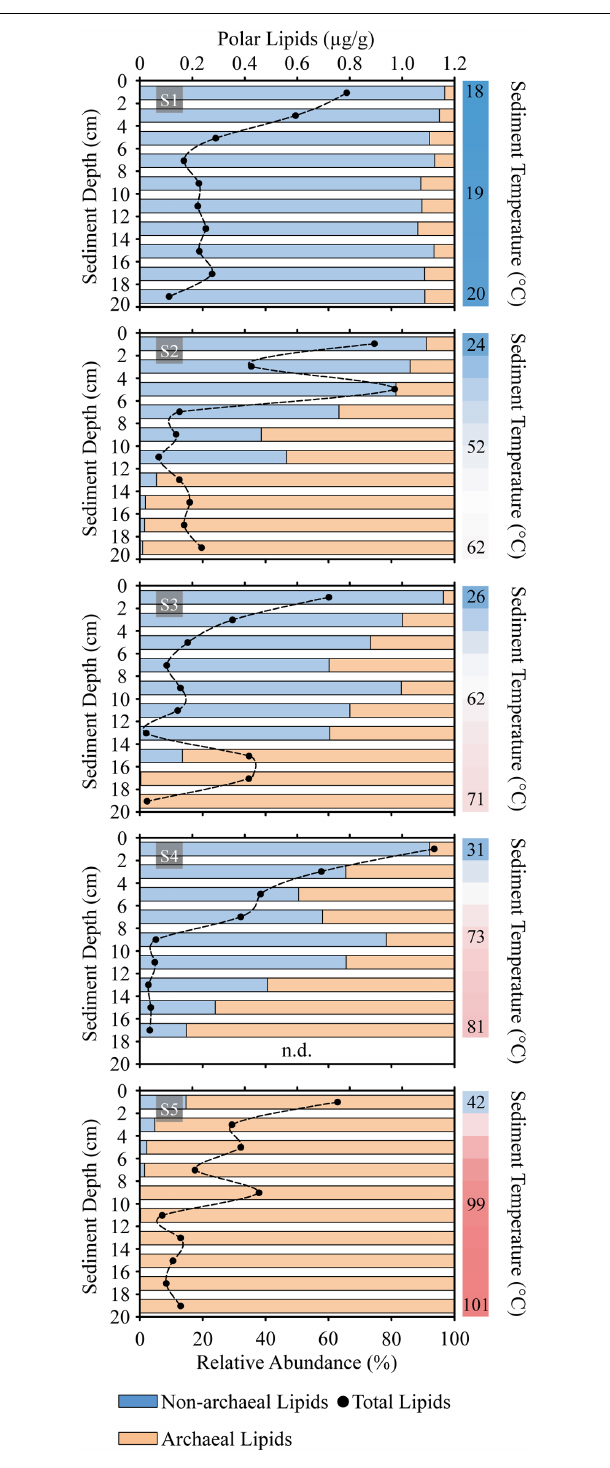
FIGURE 2 | Sediment profiles of concentration of total microbial polar lipids (dots) and distribution of archaeal vs. non-archaeal lipids (horizontal bars) in Spathi Bay. Samples were analyzed in 2 cm horizons from surface until 20 cm of sediment depth. Adjacent vertical bars indicate the thermal gradient of each station with upper, mid and bottom sediments temperatures in ◦ C. n.d., no